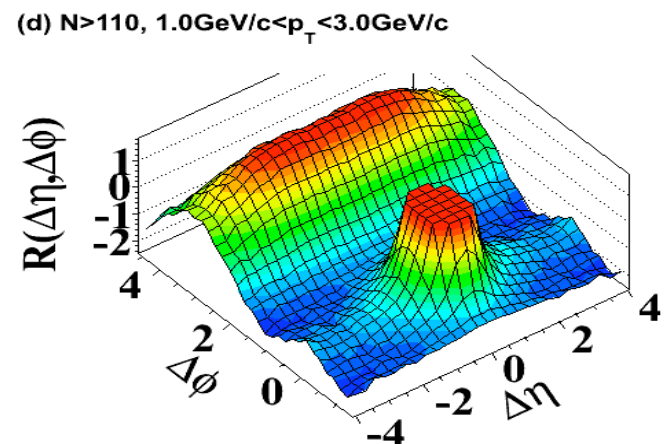
Figure 6. The peculiar ridge structure of correlations of particles created in inelastic collisions with Fig. 6. The peculiar ridge structure of correlations of particles created in high multiplicities (reproduced from CMS pp 7 TeV data [34]). Particles moving close to the detected inelastic collisions with high multiplicities (reproduced from CMS pp 7 TeV particle form a peak with other accompanying particles forming a ridge along the beam ( ∆ η ) direction. data). Particles in the opposite azimuthal direction ( ∆ φ = π ) populate a wide